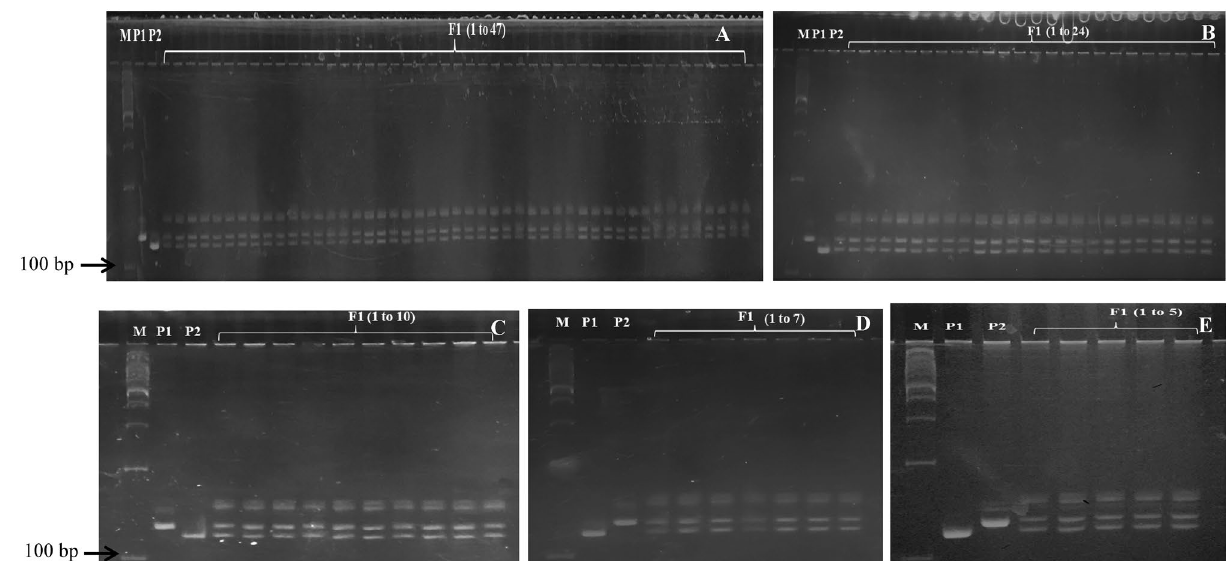
Figure 2. Molecular characterization of putative interspecific hybrids by SSR marker, CMTp182 with detection of 138 bp amplicon in crosses C. pepo × C. moschata : ( A ) HLP36 (P 1 ) × HM1343 (P 2 ), ( B ) HLP36(P 1 ) × HM1022 (P 2 ), ( C ) HLP44 (P 1 ) × HM1022 (P 2 ) and C. moschata × C. pepo : ( D ) HM1343 (P 1 ) × HLP53 (P 2 ), ( E ) HM6711(P 1 ) × HLP72 (P 2 ). M standard 100 bp DNA